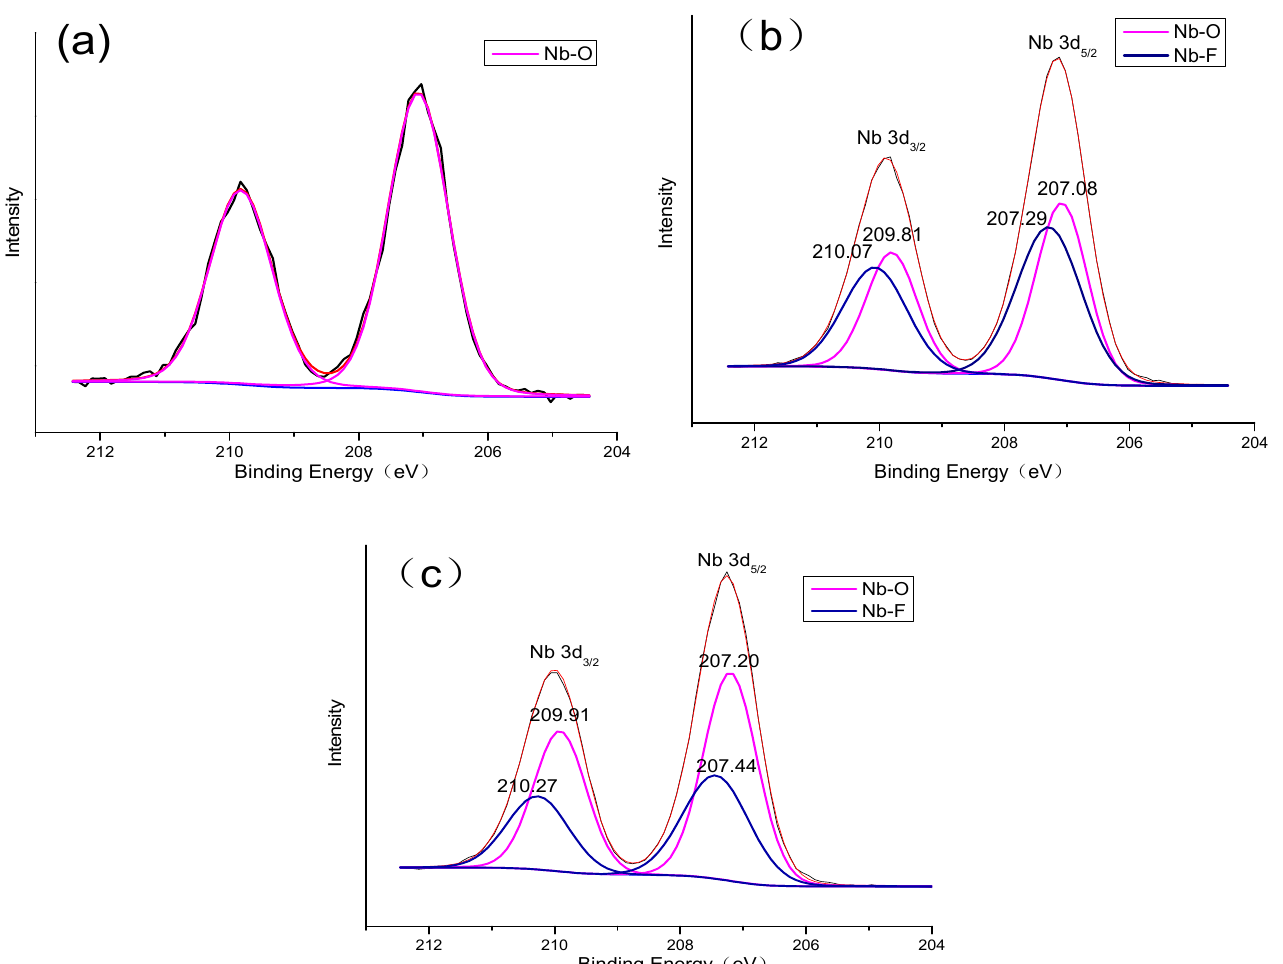
Figure 10. High-resolution XPS spectra of Nb 3d of the FeNb 2 O 6 before and after different concentrations of HF leaching: ( a ) before acid leaching; ( b ) 5 mol/L HF; ( c ) 10 mol/L HF. Table 3. ICP detection results of the solution of different concentrations of HF acid leaching